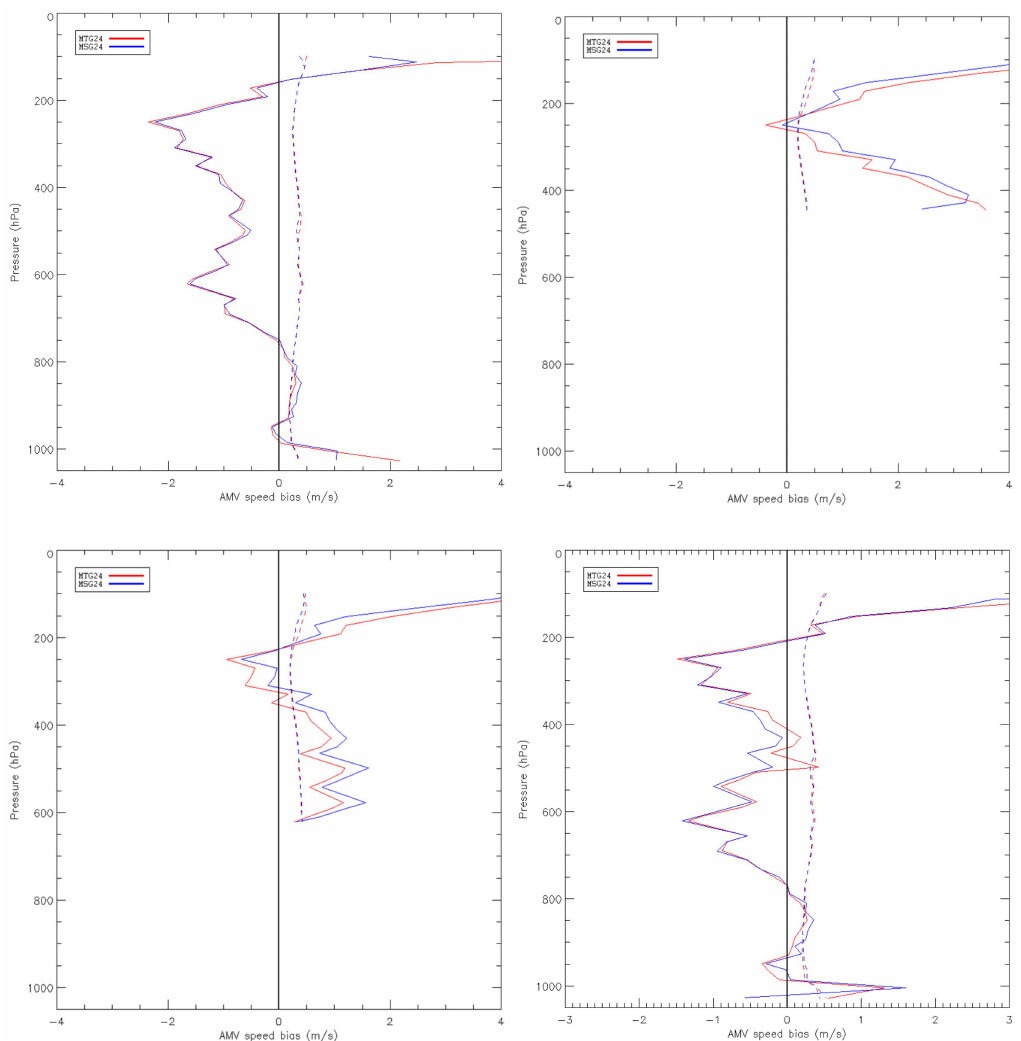
Figure 6. Vertical distribution of AMV speed bias (solid line) and normalized root mean square (NRMS) (dashed line) for the MSG / SEVIRI (blue) and MTG / FCI (red) algorithms using the VIS0.8 channel (top left), the cloudy AMVs from the WV6.2 channel (top right), the cloudy AMVs from the WV7.3 channel (bottom left), and the IR10.8 channel (bottom right). MSG data from 14 May to 14 June 2016 were used for these